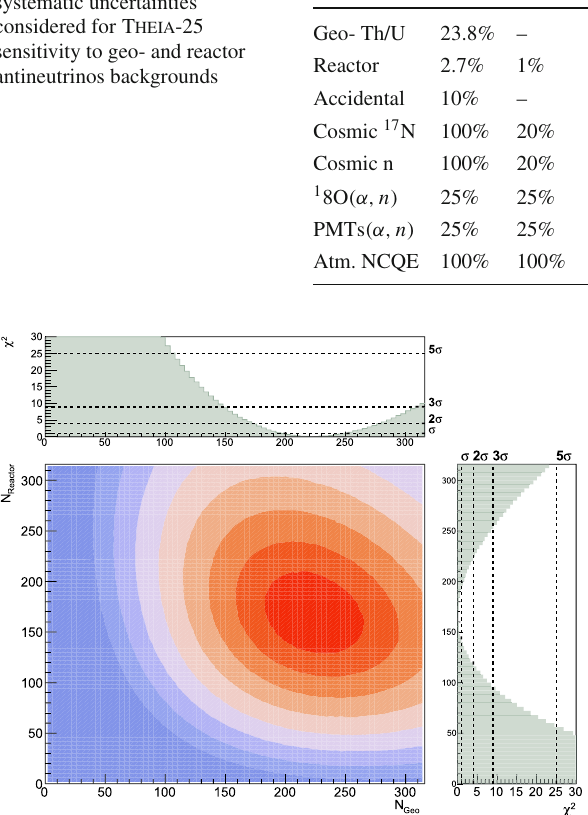
Fig. 11 2-Dconfidencelevelofthegeoneutrinoversusreactorantineu- trinos flux after one year of data taking, assuming systematic uncer- tainties from Table 10, and estimated with 1000 toy experiments. The confidence level are drawn for [ 1 σ, 8 σ ] . The individual projection for each contribution at the best fit position is also shown with the statistical significance as dashed